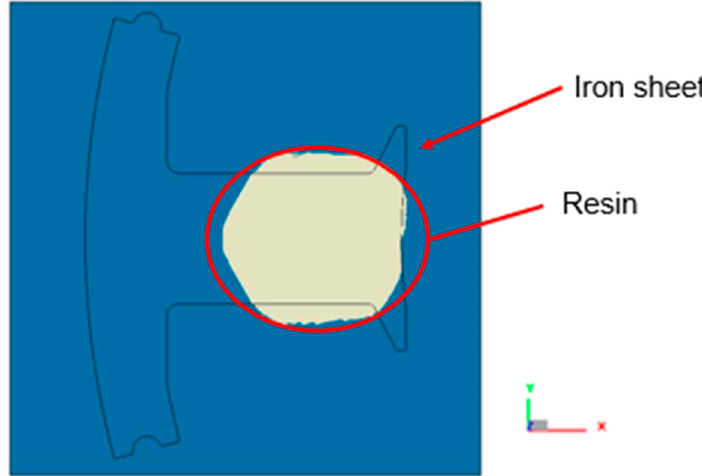
Figure 15. Top view of the dipping process results of Case 1.